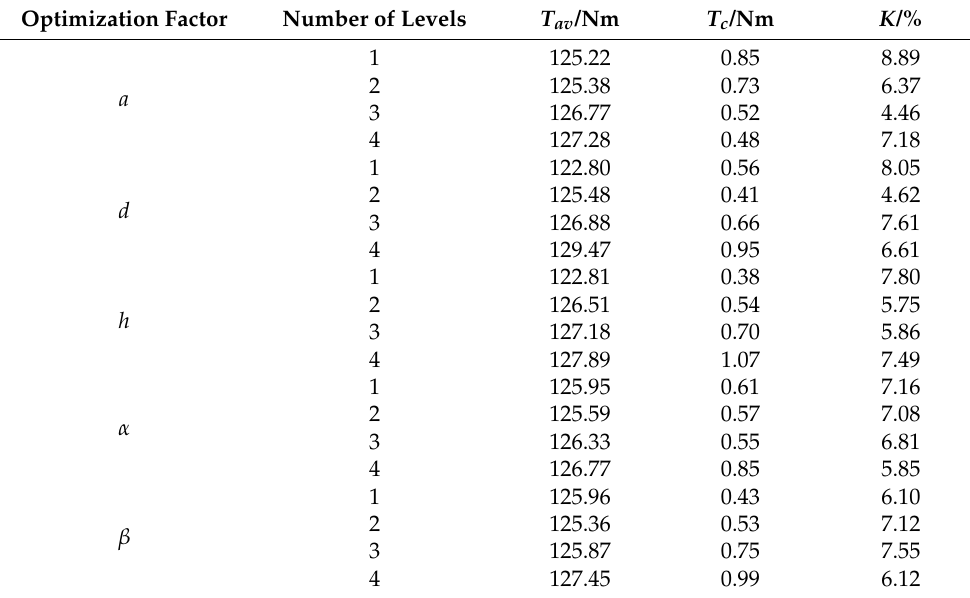
Table 9. The average value of motor performance indexes of various optimization factors at different levels.